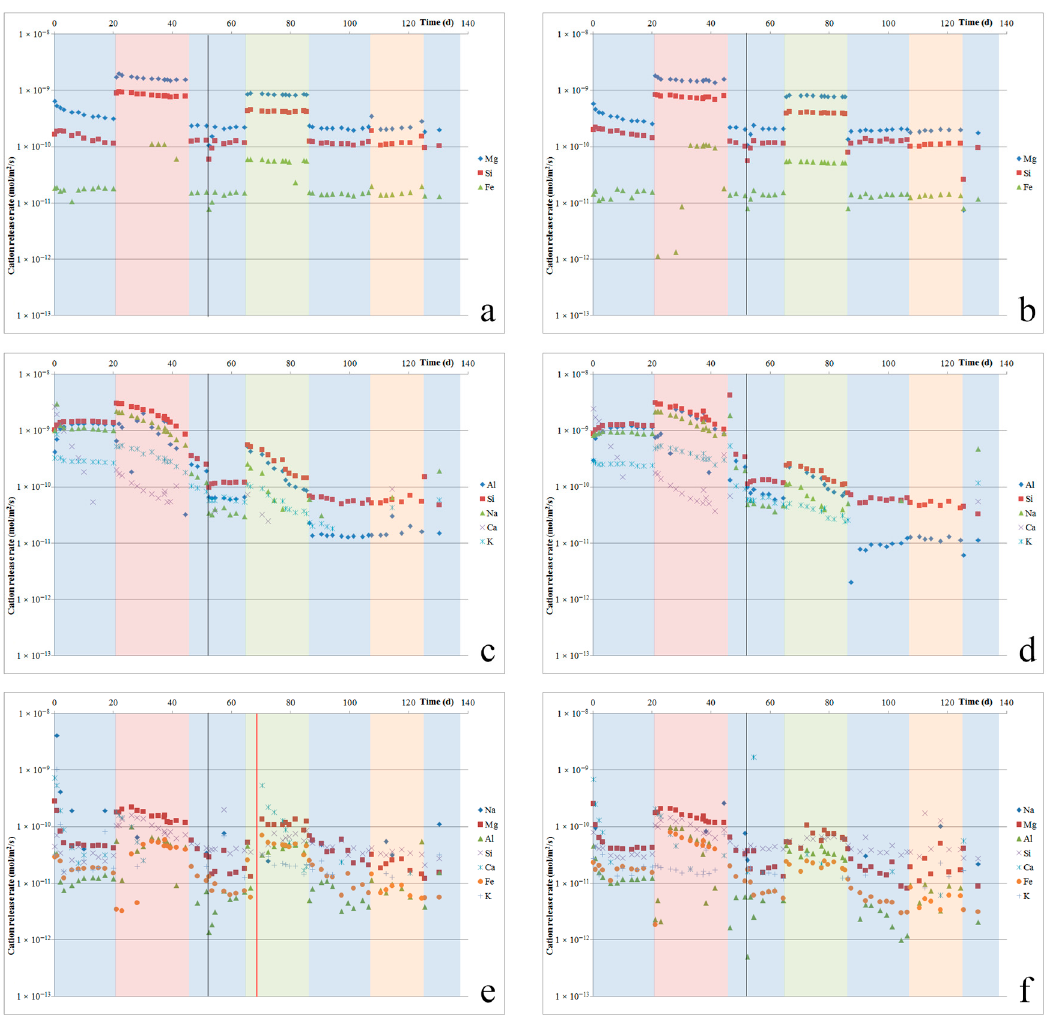
Figure 2. Major element release rates per sample plotted against experimental duration, for Åheim dunite ( a , b ), nepheline syenite ( c , d ), and ilmenite norite ( e , f ). Colored bands illustrate when different acids were used (blue = hydrochloric; red = oxalic; green = citric; orange is nitric acid). The black line at 51 days indicates when the experiment was paused, and the cells were filled with stagnant Milli-Q water for 48 days. The red line in ( e ) indicates when the sample was replaced with fresh unreacted powder.